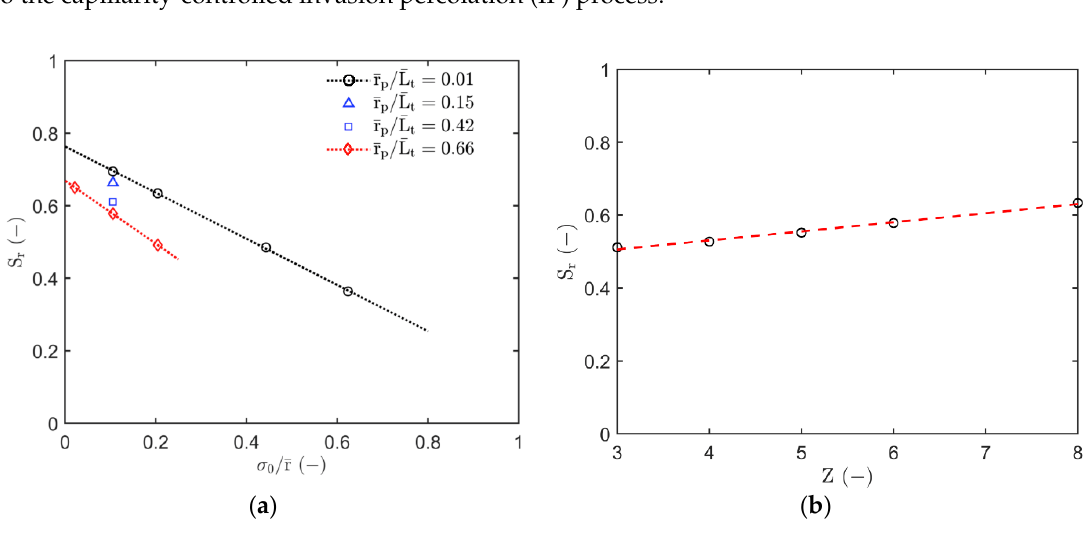
(Figure 3a), the ratio 𝑟̅ 𝑝 𝐿̅ 𝑡 ⁄ indicates the role of spherical pore volume in the